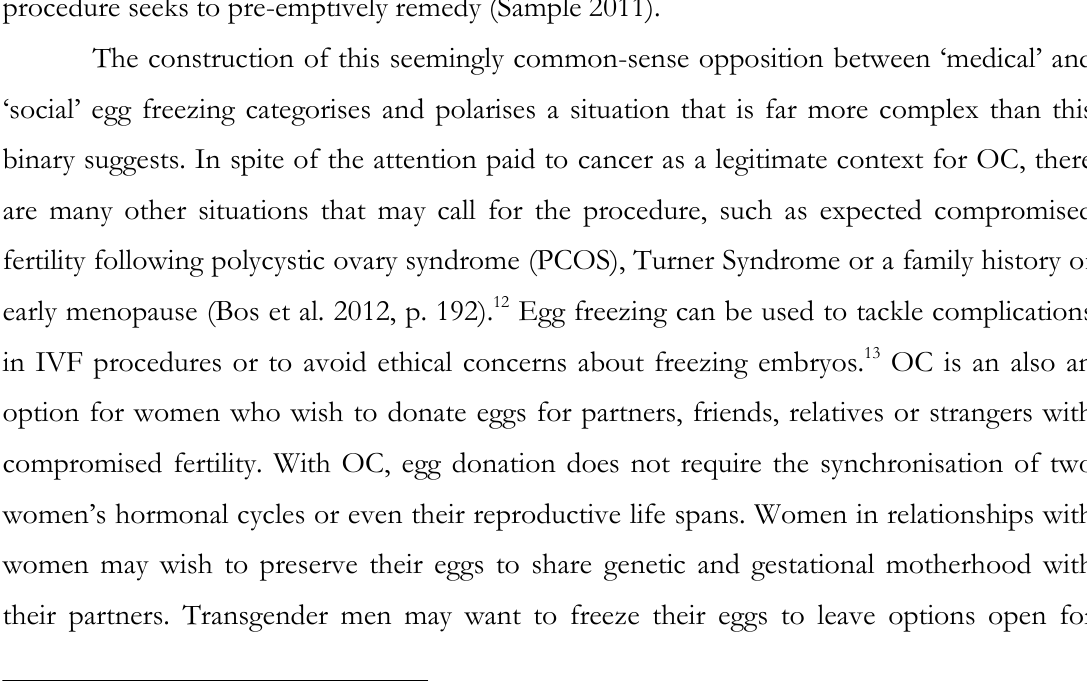
Lucy van de Wiel, For Whom The Clock Ticks: Reproductive Ageing and Egg Freezing in Dutch and British News Media Studies in the Maternal , 6(1), 2014,